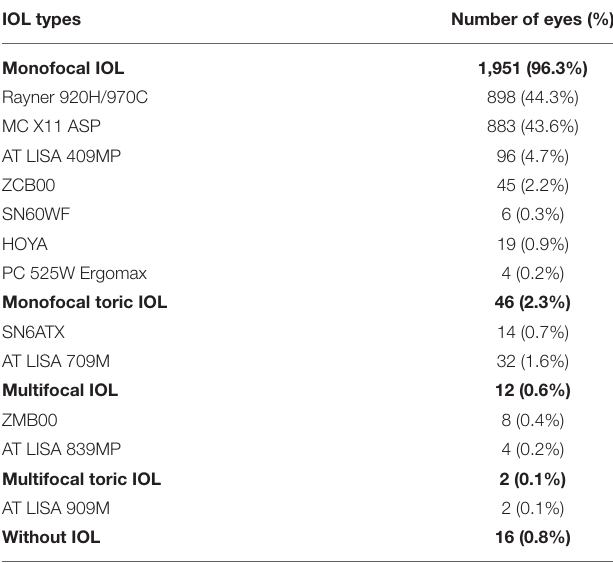
TABLE 3 | IOL used in highly myopic cataract